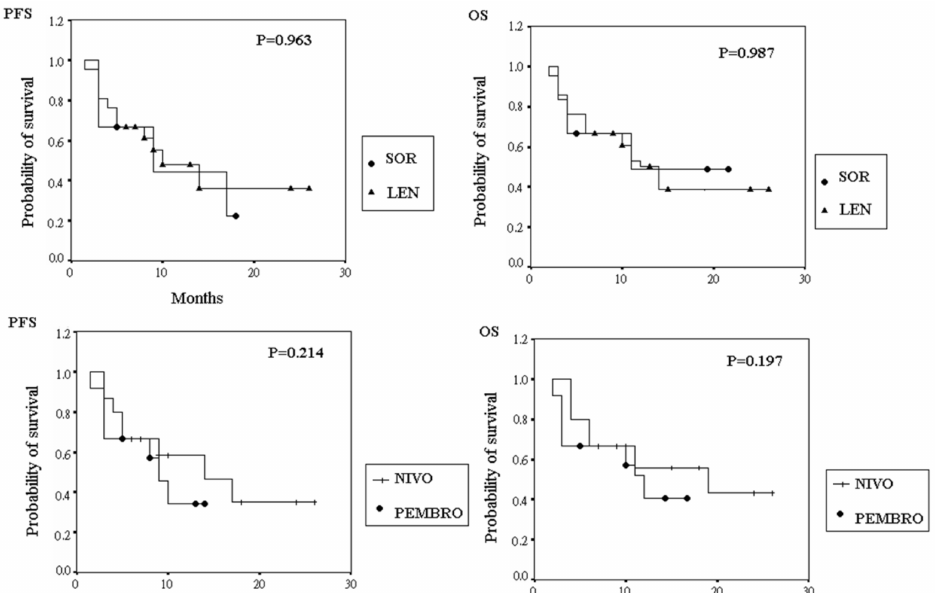
Figure 2. The survival time of hepatocellular carcinoma patients receiving different tyrosine kinase inhibitors and immune checkpoint inhibitors. (LEN, lenvatinib; NIVO, nivolumab; OS, overall survival; PEMBRO, pembrolizumab; PFS, progression free survival; SOR, sorafenib).